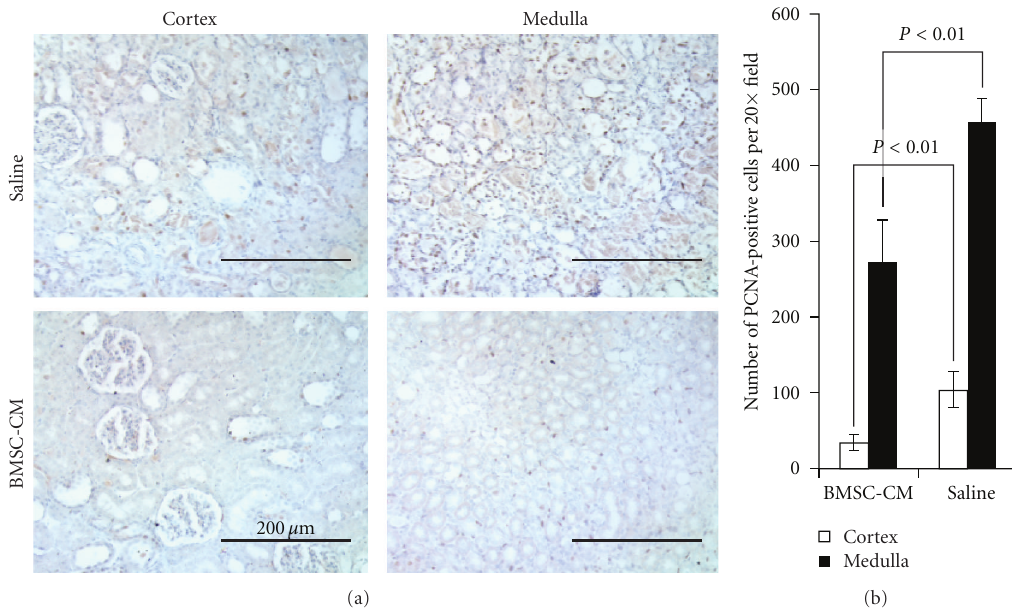
Figure 5: Vehicle treated have a greater number of PCNA+ cells 5 days after cisplatin administration. (a) PCNA staining was performed on sections of formalin fixed and para ffi n-embedded kidneys from rats administered a lethal dose of cisplatin (7.5mg/kg) and sacrificed at 5 days following cisplatin administration. The rats were treated at 3, 9, 24, 48 and 72 hours following cisplatin administration, with 1mL of either physiological saline ( n = 4), or BMSC conditioned medium ( n = 3) i.v. (b) Quantification of the PCNA positive cells per field of view. Scale bar = 200 μ